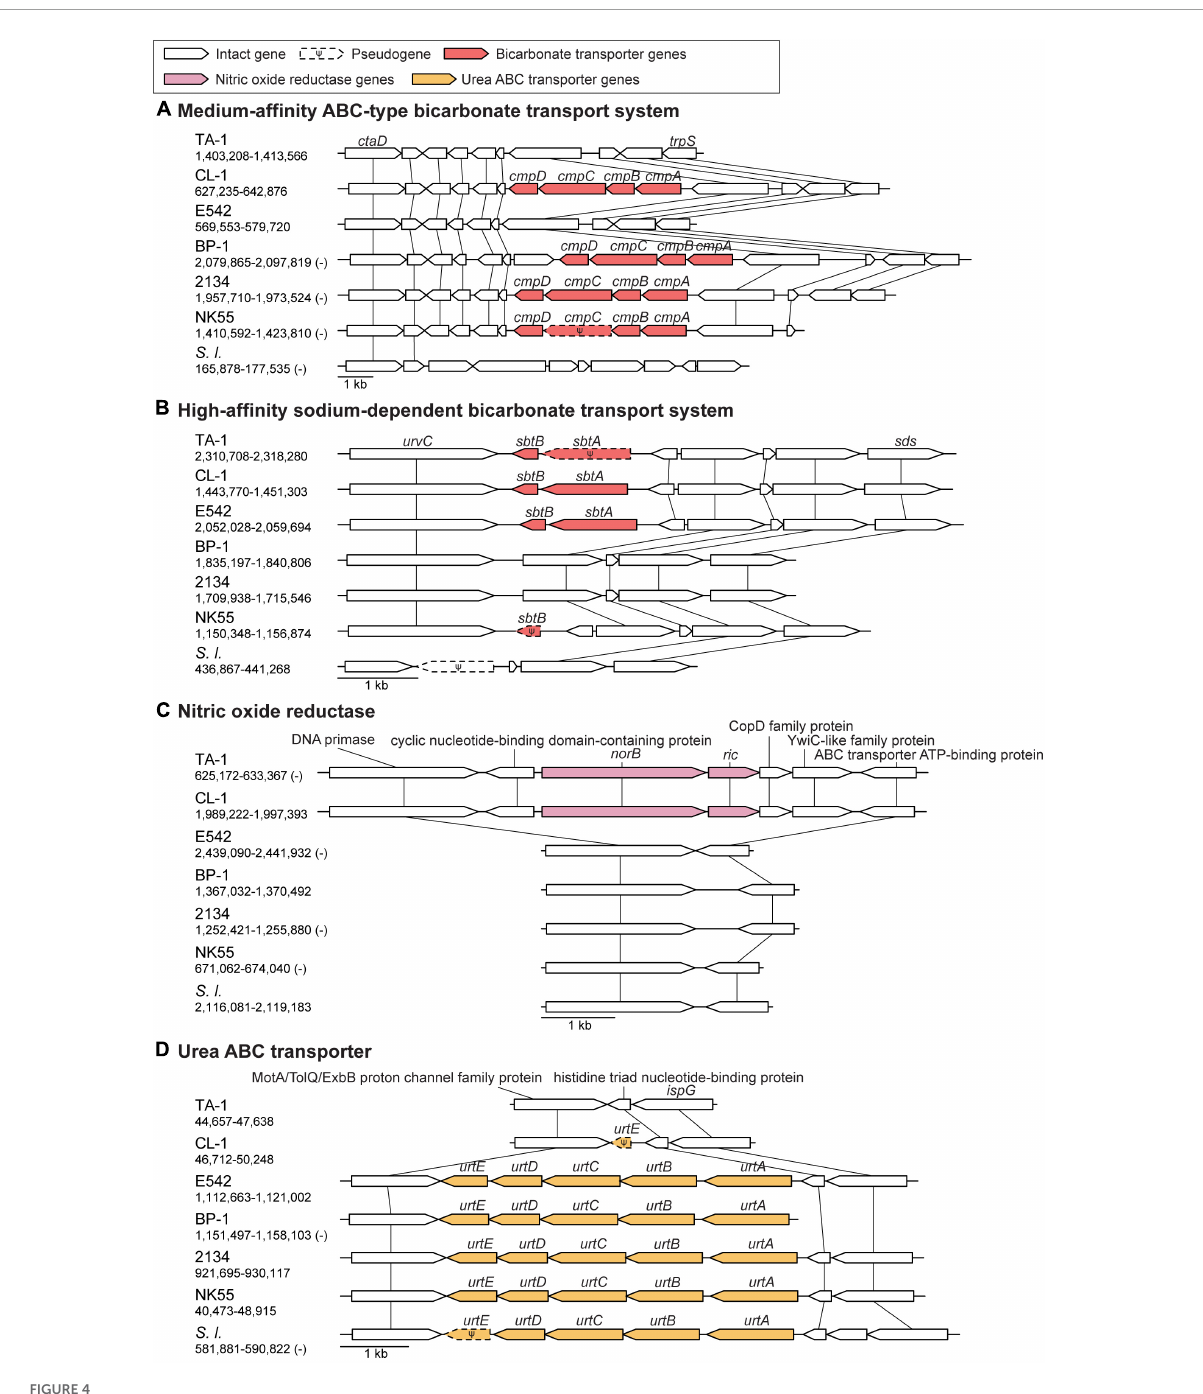
FIGURE4 Synteny plots of notable genes. Chromosomal locations are labeled below strain name abbreviations on the left. Homologous genes are linked by vertical lines. (A) ABC-type bicarbonate transport system. (B) Sodium-dependent bicarbonate transport system. (C) Nitric oxide reductase gene cluster. (D) Urea ABC transporter gene